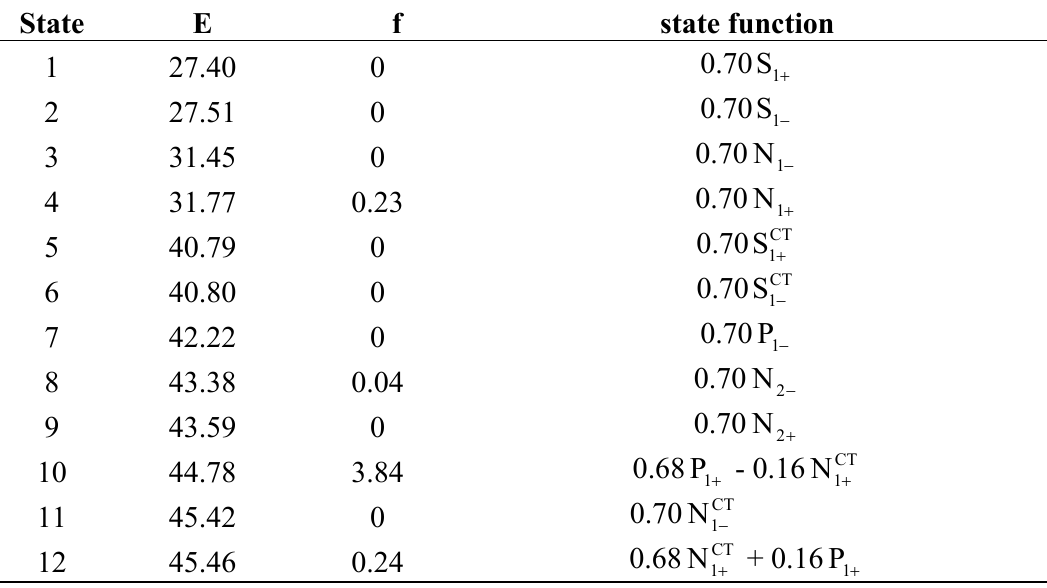
Table 5. Calculated Electronic Transitions for [2,2]Biphenylenophane in J-Aggregation, the Head-to-Tail Arrangement. a [51]. Reproduced with permission from American Chemical Society.